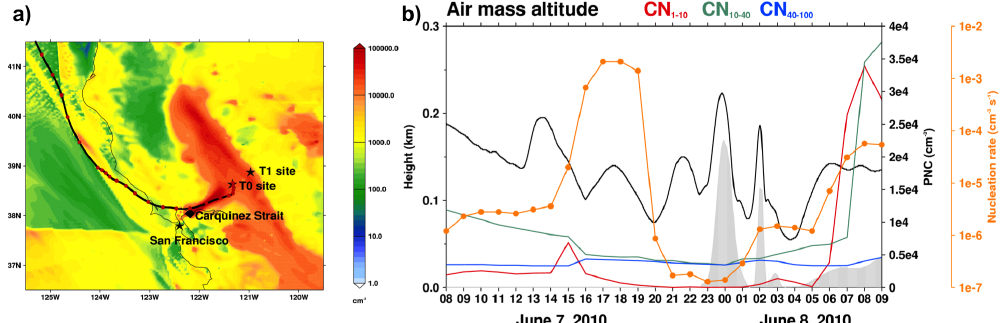
Figure 7. (a) Nucleation budget term (cm − 3 h − 1 ) averaged over the first five model layers from 05:00 to 09:00PST on 8 June 2010 from the ACT simulation, together with a backward trajectory from 08:00PST on 7 June to 09:00PST on 8 June 2010; the red dots denote the hourly locations of the air mass prior to its arrival at the T0; (b) altitude of the air mass (black line) together with particle number concentration in the 1–10nm diameter range (red line), 10–40nm range (green line), 40–100nm range (blue line) and nucleation rate (orange circled line); the gray area denotes the terrain height.